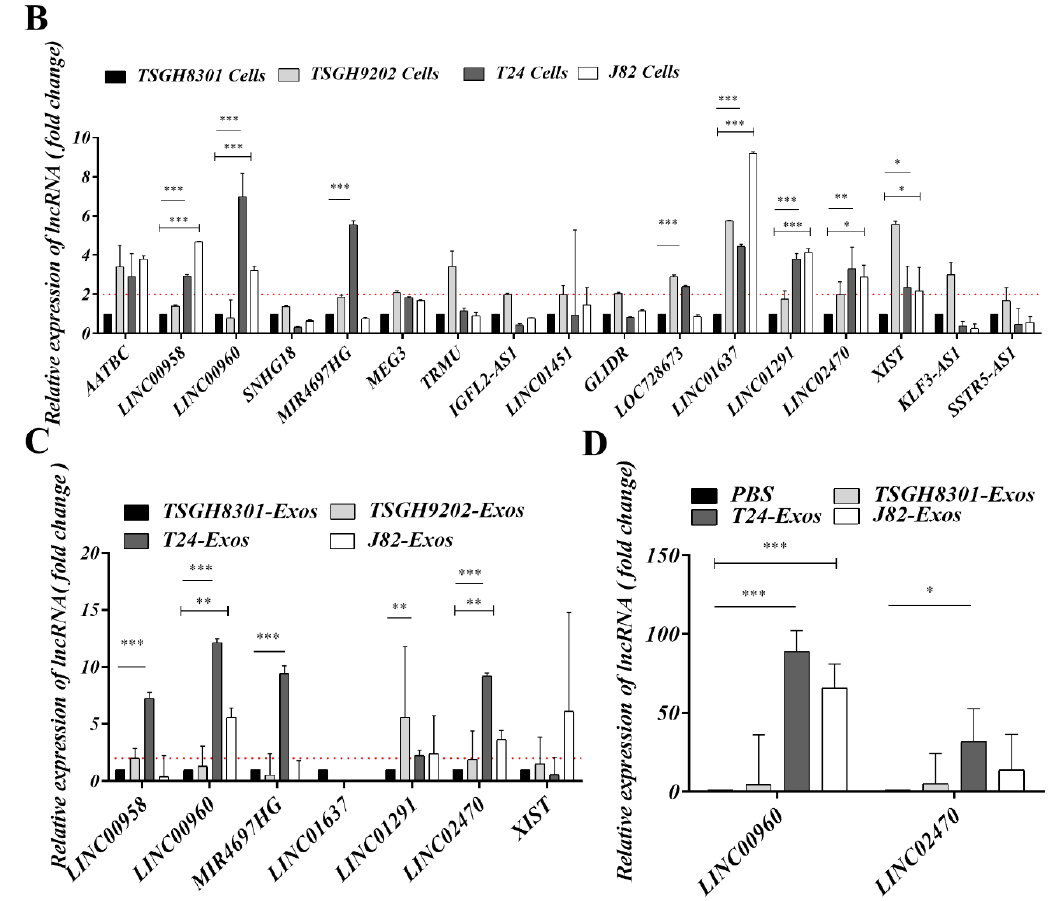
Figure 5. Screening and validation of lncRNA candidates. ( A ) Schematic diagram of lncRNA screening. Seventeen candidate lncRNAs were screened from the intersection between the top 200 lncRNA of normal vs. tumor and low-grade vs. high-grade bladder cancer datasets in the lnCAR database. ( B ) Intracellular expression levels of AATBC, LINC00958, LINC00960, SNHG18, MIR4697HG, MEG3, TRMU, IGFL2-AS1, LINC01451, GLIDR, LOC728673, LINC01637, LINC01291, LINC02740, XIST, KLF3-AS1, SSTR5-AS1wereamongthedi ff erentbladdercancercellsthatwerecomparedusingRT-qPCR. ( C ) Exosomal levels of LINC00958, LINC00960, MIR4697HG, LINC01637, LINC01291, LINC02740 and XIST were also compared using RT-qPCR. ( D ) Exosome-derived LINC00960 or LINC02470 transferred experiments, * p < 0.05, ** p < 0.01, *** p <